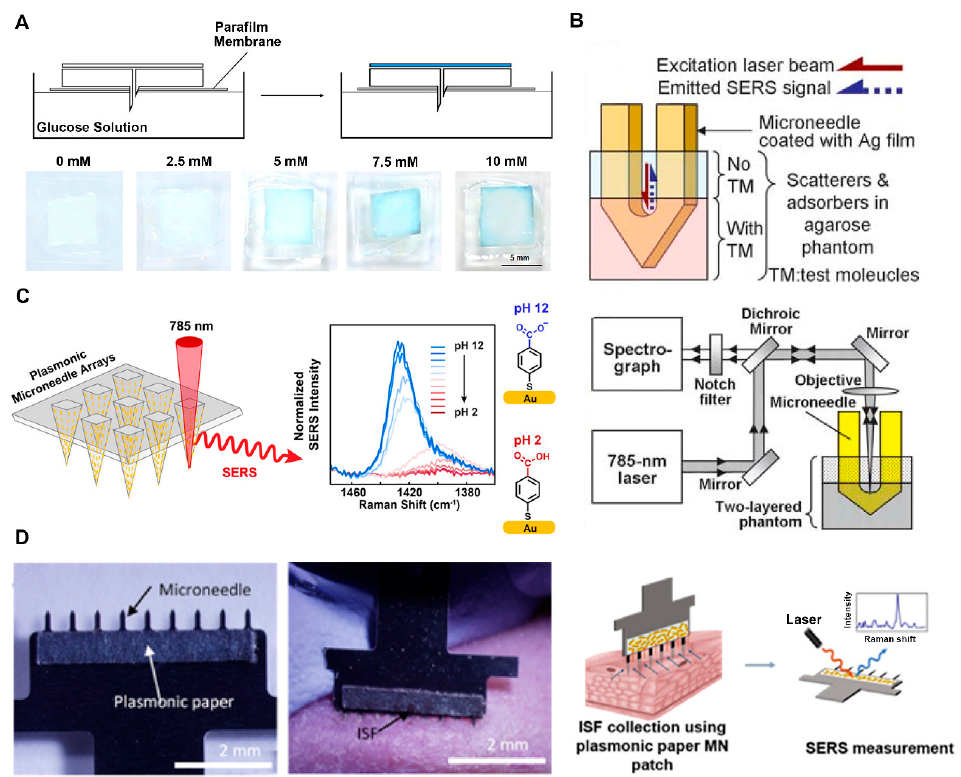
Figure 5. ( A ) Schematic illustration of a paper-based rapid colorimetric glucose sensor (top) and digital photographs of glucose-responsive backplates after addition of different concentrations of glucose(down) (reproduced with permission from the authors of [122]). ( B ) Schematic illustration of Ag-coated MN in two-layered human skin mimic (top) and Raman system for surface-enhanced Raman scattering (SERS) measurement (down) (reproduced with permission from the authors of [126]). TM, test molecules. ( C ) Schematic representation of plasmonic MN array for in situ pH measurement by SERS (reproduced with permission from the authors of [127]). ( D ) Photographs of MN patch with a plasmonic paper (left) and interstitial fluid (ISF) collection through MN penetrating into hairless rat (middle) and schematic illustration of SERS analysis of the plasmonic paper MN with target (right) (reproduced with permission from the authors of [128] ).